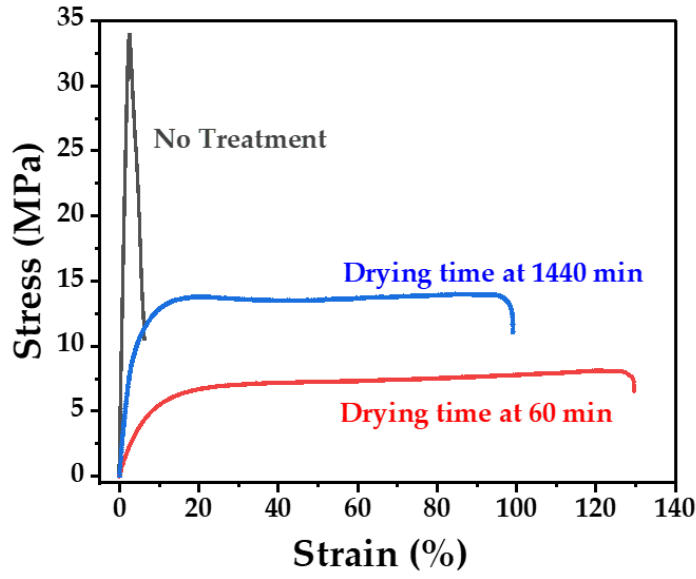
Figure 4. Stress-strain curves of PLA filaments for each drying time after pre-treatment with ace-